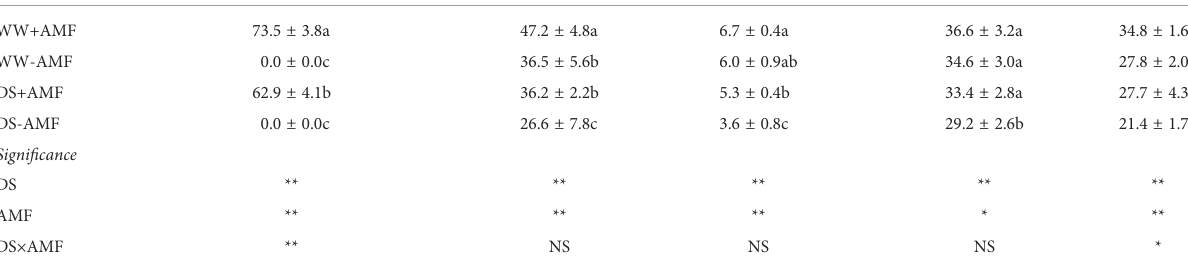
TABLE 2 Effects of AMF ( Diversispora spurca ) on root mycorrhizal colonization and plant growth performance of walnut under well-watered (WW) and drought stress (DS). Treatments Root mycorrhizal colonization (%) Plant height(cm) Stem diameter(mm) Leaf number per